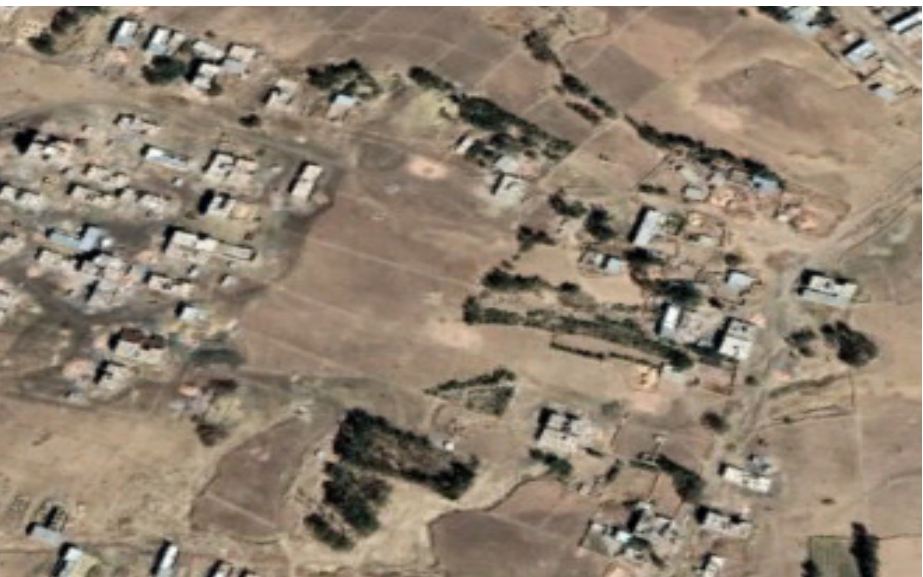
Figure 2. Site layout of the study area [Google Map 2019 edition].